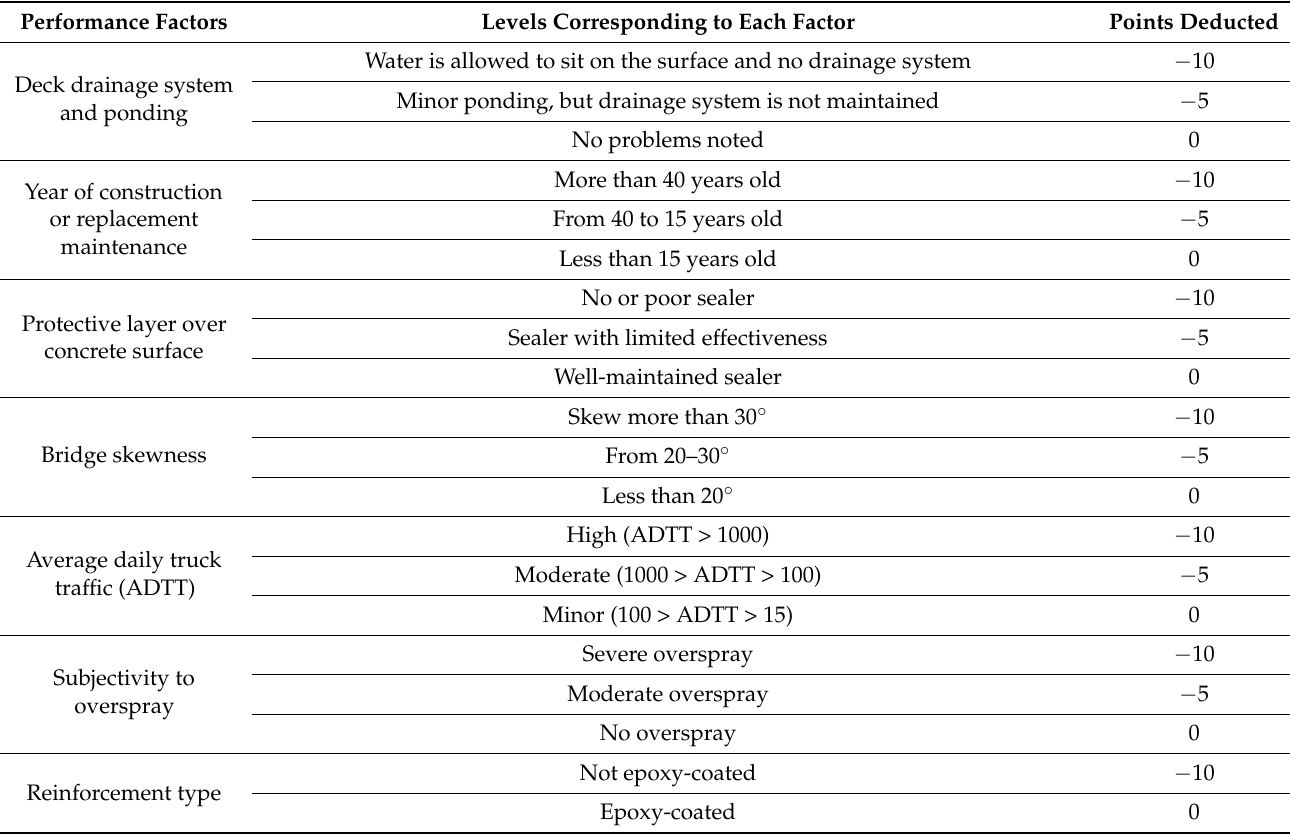
Table 2. The levels corresponding to each P&C factor, and associated points